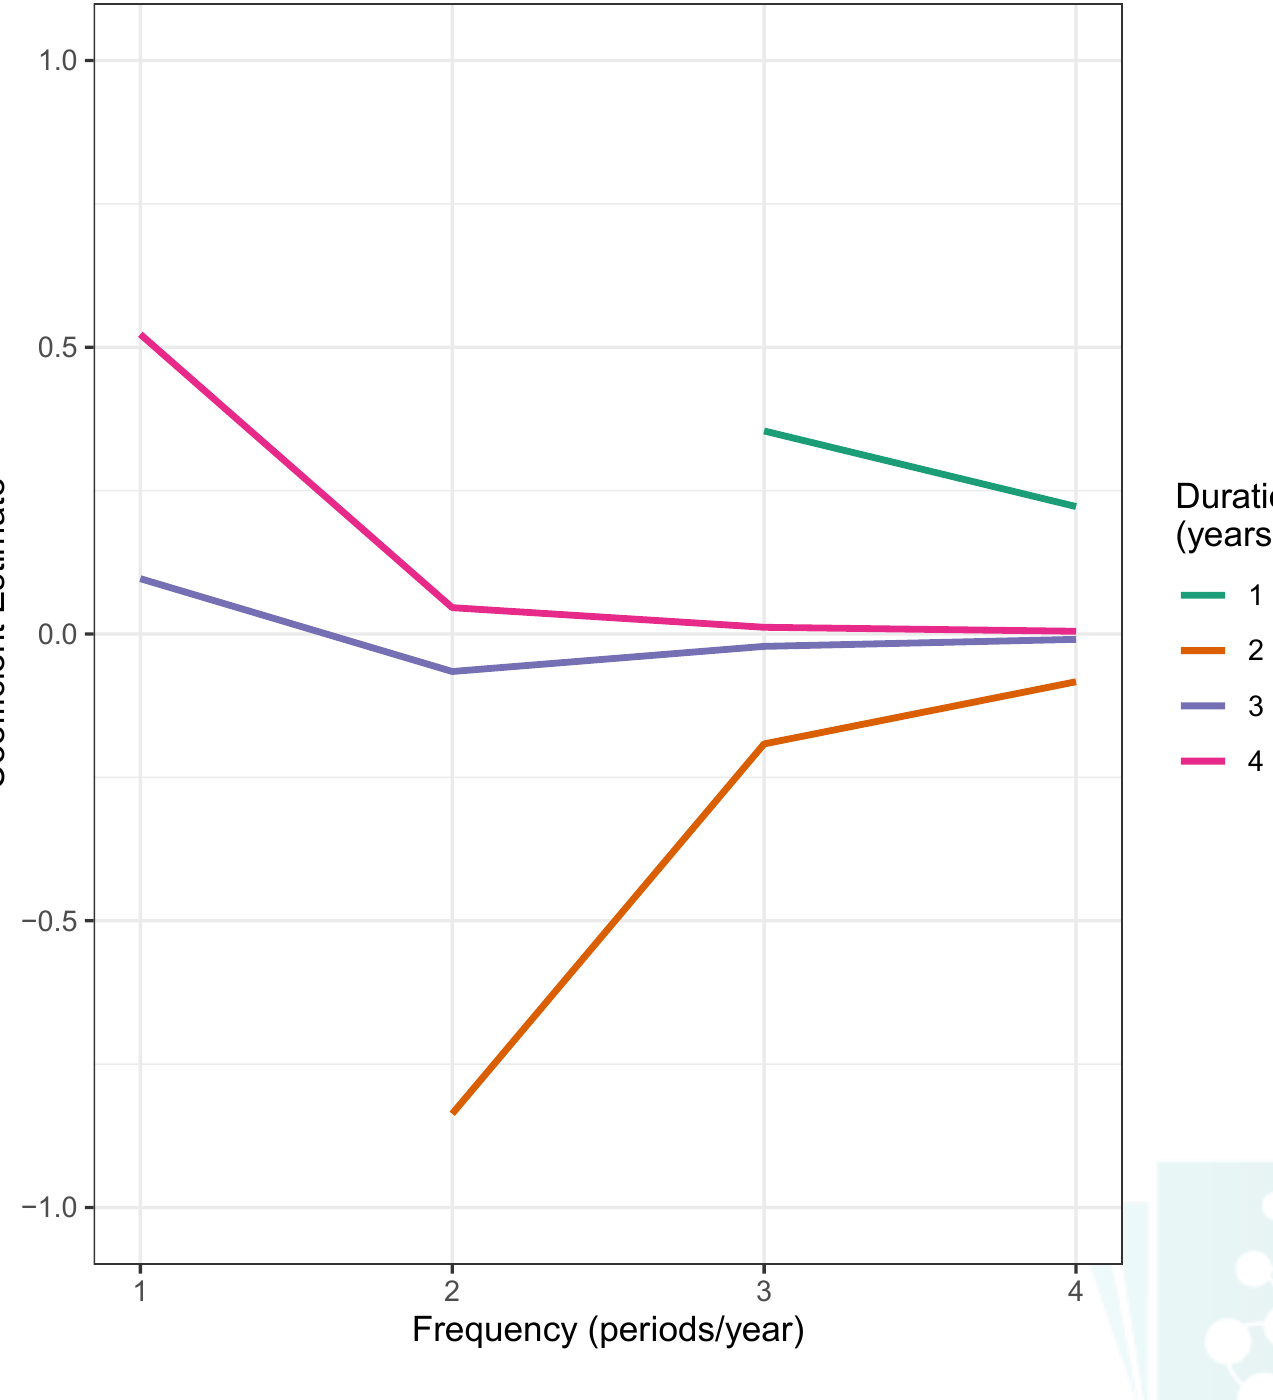
Figure 2: Estimated coefficients of the Group-Time-Time interaction term for combinations of study duration and frequency of outcome